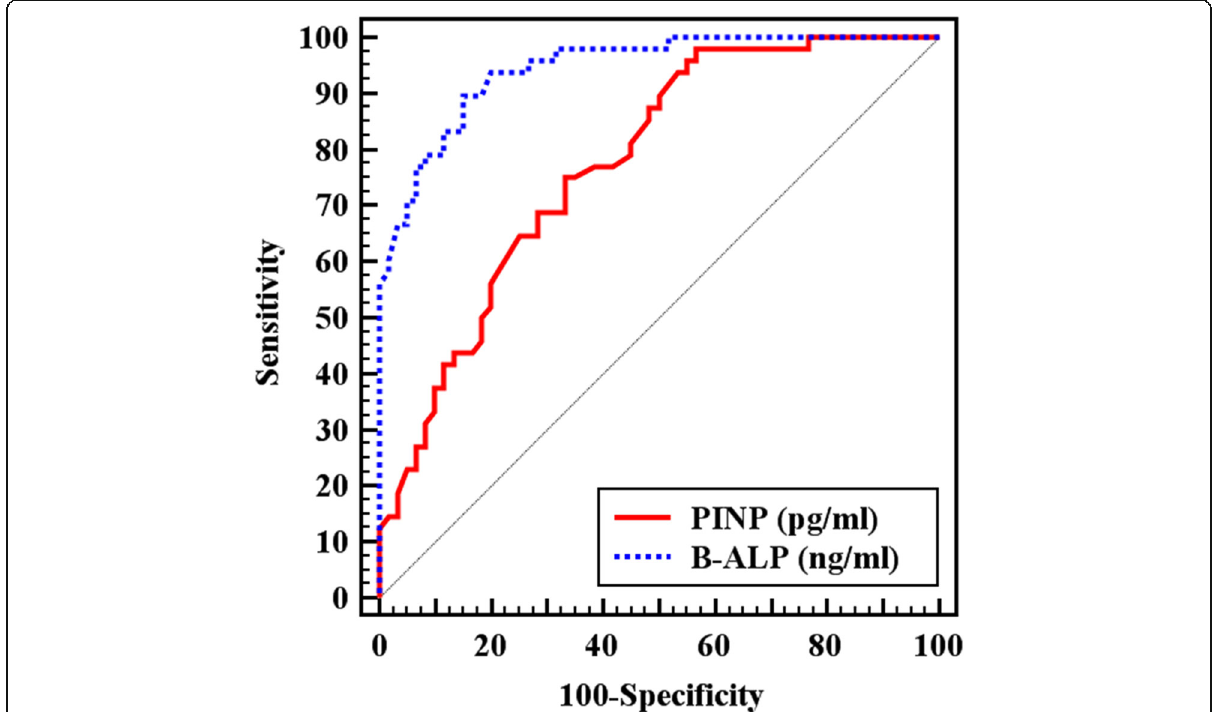
Fig. 1 ROC curve for PINP and B-ALP to discriminate osteopenia patients from healthy control